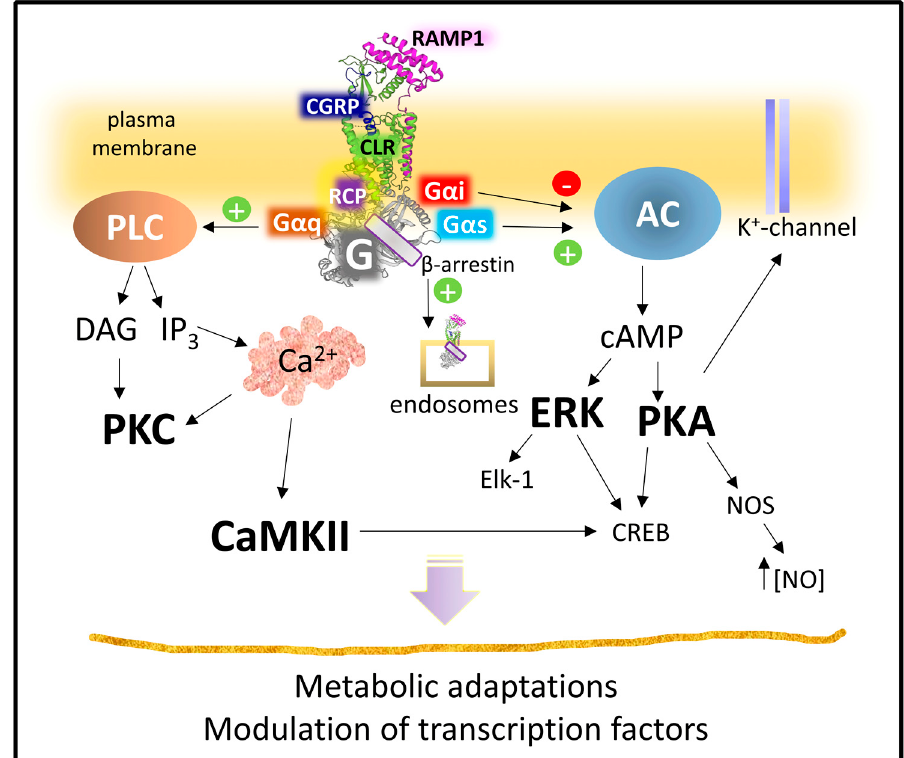
Figure 12. Signaling pathways activated by CGRP receptor. Abbreviations: CaMKII, calcium-calmodulin kinase II; cAMP, cyclic adenosine 5 ′ monophosphate; CLR, calcitonin receptor-like receptor; CREB, cAMP-response element binding protein; DAG, diacylglycerol; Elk-1, ETS-erythroblast transformation specific-like protein; ERK, extracellular receptor kinase; IP3, inositol 1,4,5-trisphosphate; NOS, nitric oxide synthase; PKA, protein kinase A; PKC, protein kinase C; RAMP1, receptor activity modifying protein 1; RCP, receptor component protein (see text for details).